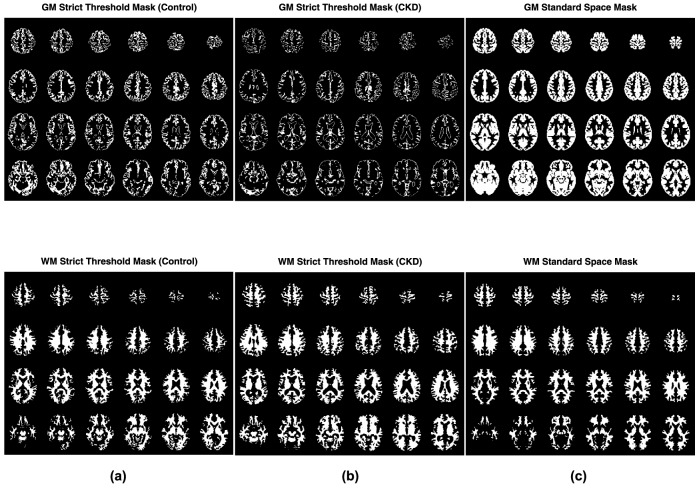
GM (top rows) and WM (bottom rows) masks used for calculating mean CV in these two tissue types: The GM and WM threshold masks derived from partial volume estimation (PVE) maps (PVE threshold>0.8) for representative (a) control and (b) CKD subjects.ICBM152 standard GM and WM template masks are shown in column (c), and were, of course, independent of the cohort group.